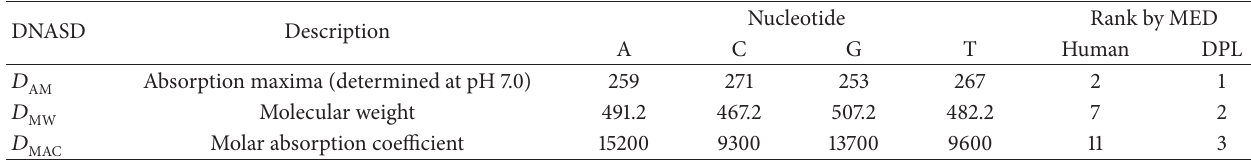
Table 3: Three physicochemical properties of nucleotide.